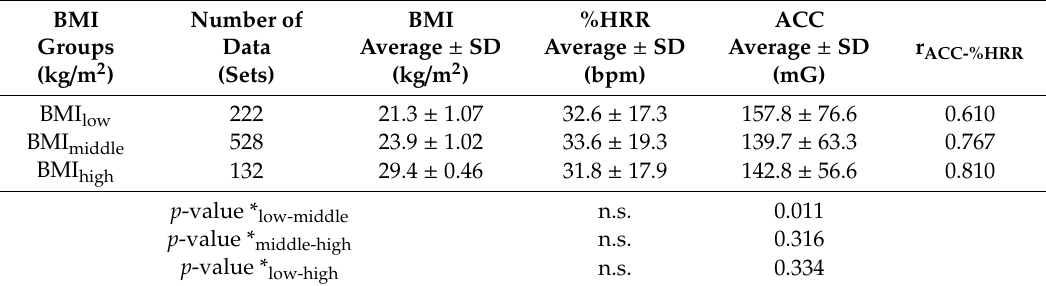
Table 7. Overview of subjects’ BMI and relationship between ACC and